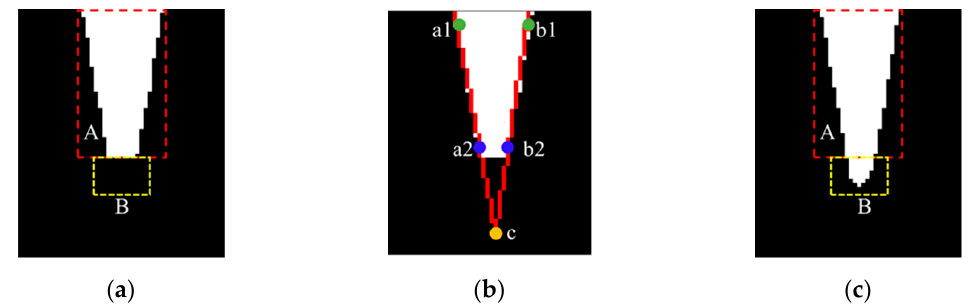
Figure 10. Appl. Sci. 2019 , 9 , x FOR PEER REVIEW